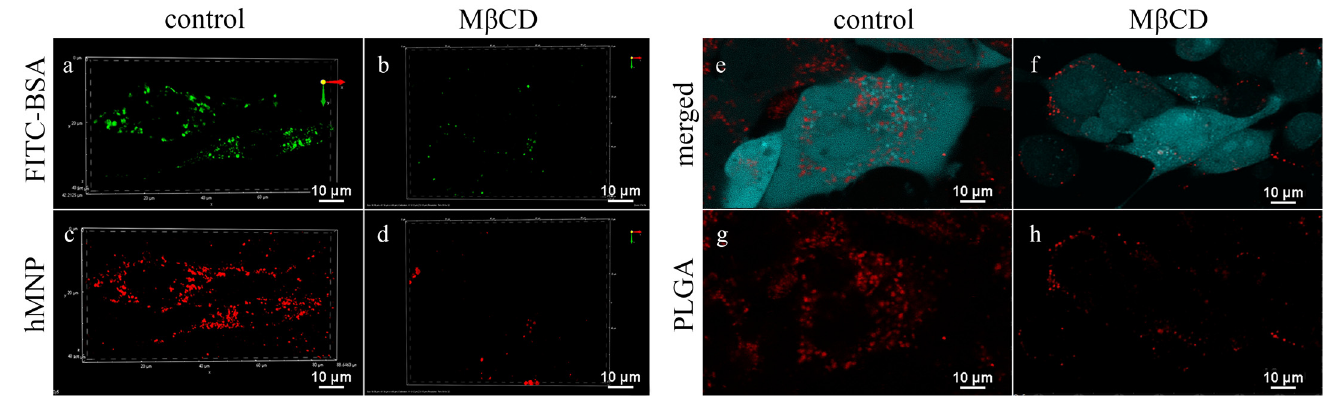
Figure 6. Investigation of hMNP-Cy3 and PLGA-Cy5 NP uptake mechanism by 4T1-mScarlet cells (60 min of incubation). ( a ) Control—FITC-BSA. ( b ) FITC-BSA internalization into cells treated with M β CD. ( c ) hMNP-Cy3 internalization into untreated cells (control). ( d ) hMNP-Cy3